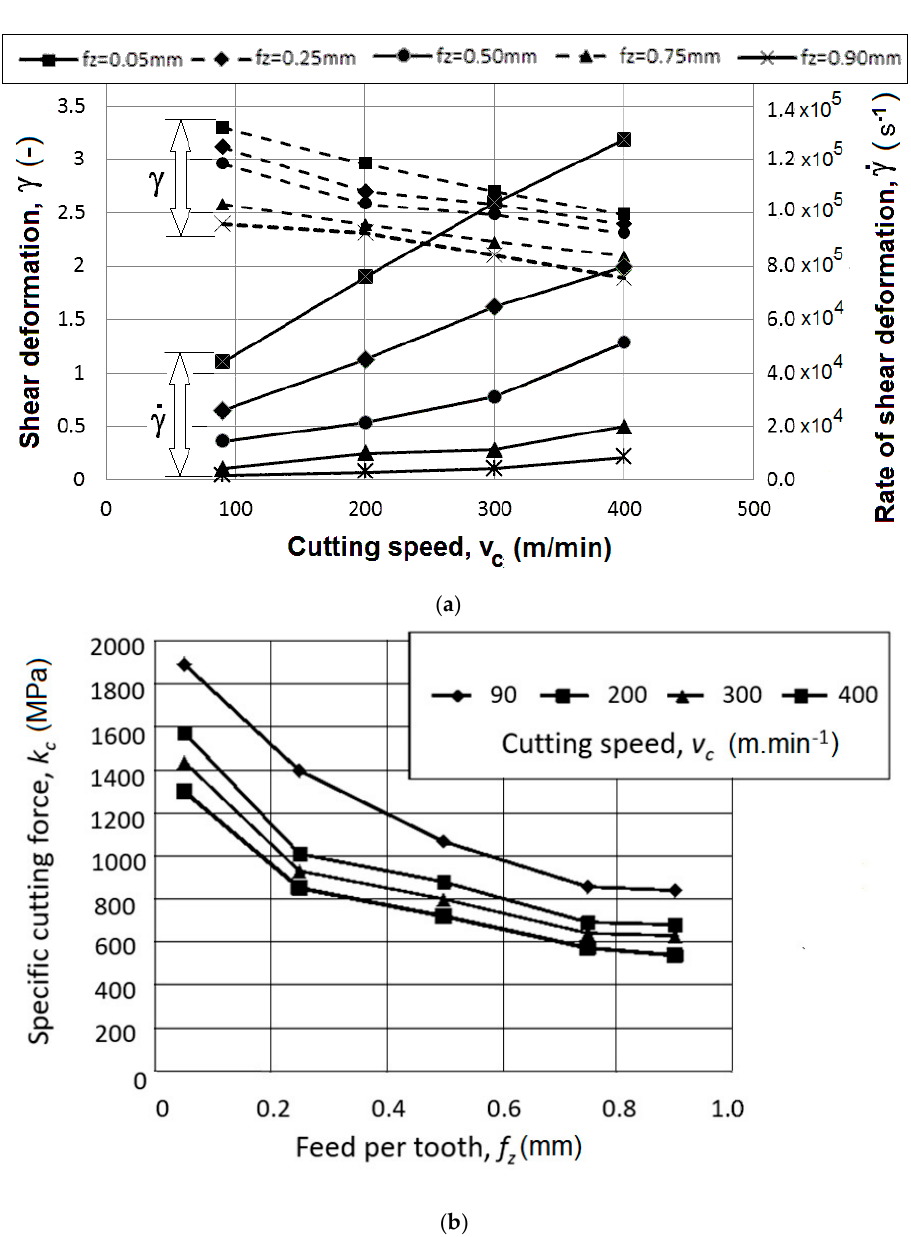
Figure 16. ( a ) The calculated mean values of the shear deformation and the rate of shear deformation in the primary zone; ( b ) Specific cutting forces for the given cutting conditions. in the primary zone; ( b ) Specific cutting forces for the given cutting